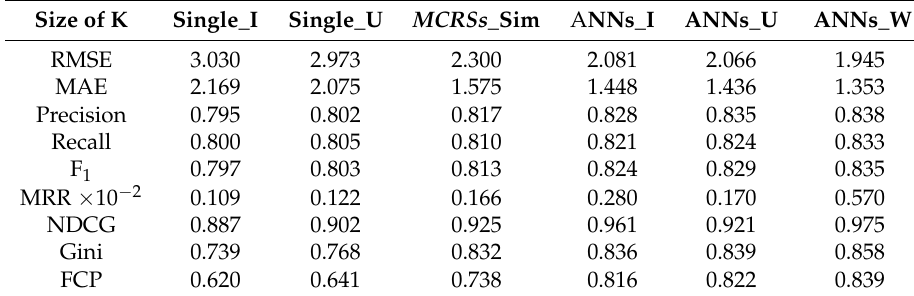
Table 4. Evaluation results. FCP: fraction of concordant pairs; MRR: mean reciprocal ranking; NDCG: normalized discounted cumulative